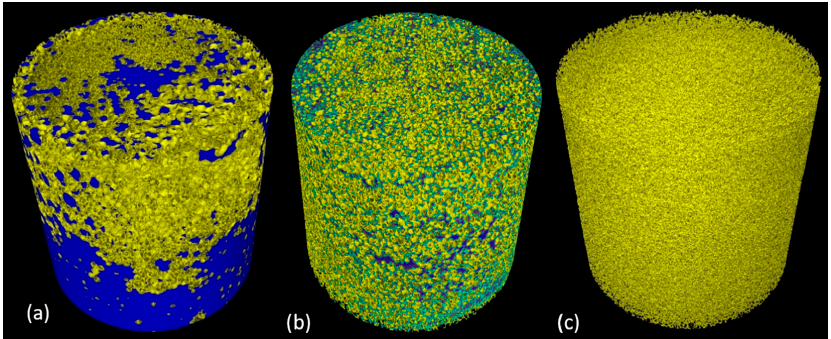
Figure 5. 3D rendering of sponge with brominated vegetable oil dispersed olive oil ( a ) before cleaning, ( b ) intermediate Process 3 (Section 2.7) and ( c ) after two stages of cleaning. Pseudo coloration is performed based on the segmentation: blue represents brominated vegetable oil with olive oil, pale blue represents water, red represents detergent and yellow colour represents the sponge. There were no traces of contrasted olive oil in the cleaned sponge.